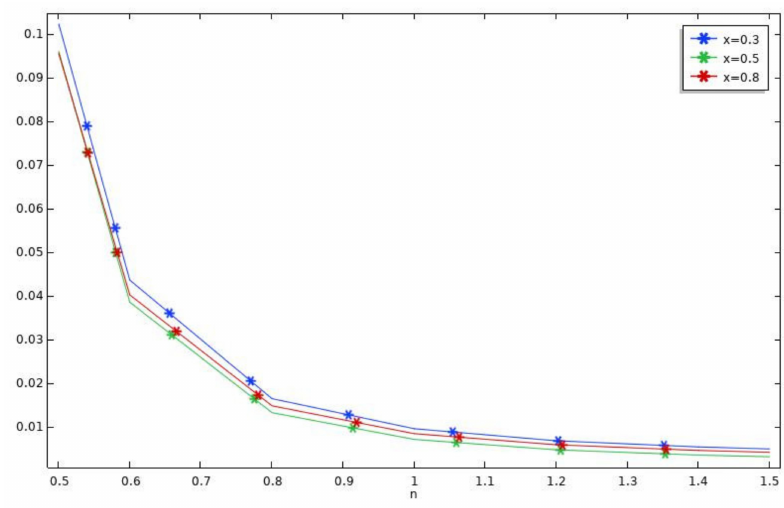
Figure 12. Kinetic energy graphs against different cutlines for varying ( n ) .